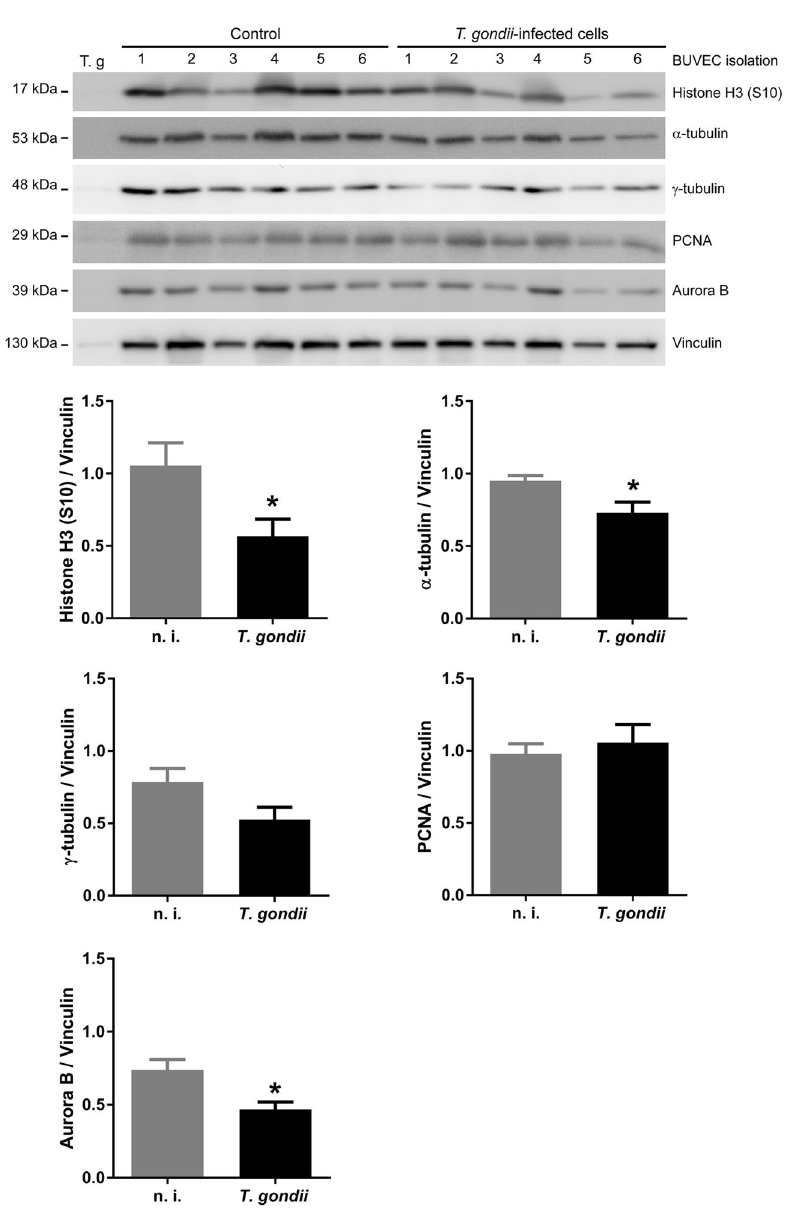
Figure 4. Histone H3, α -tubulin, γ -tubulin, PCNA and Aurora B expression in T. gondii -infected BUVEC. Protein extracts from non-infected and T. gondii- infected BUVEC (six biological replicates) were subjected to Western blotting and analyzed for Histone H3 (S10), α -tubulin, γ -tubulin, PCNA and Aurora B expression. Pure T. gondii tachyzoites were analyzed in parallel for control reasons. The density of the protein signals was quantified and graphed as ratio relative to vinculin as housekeeping protein. Bars represent the median ± SEM. Bars represent the median ± SEM. t- test, * p ≤